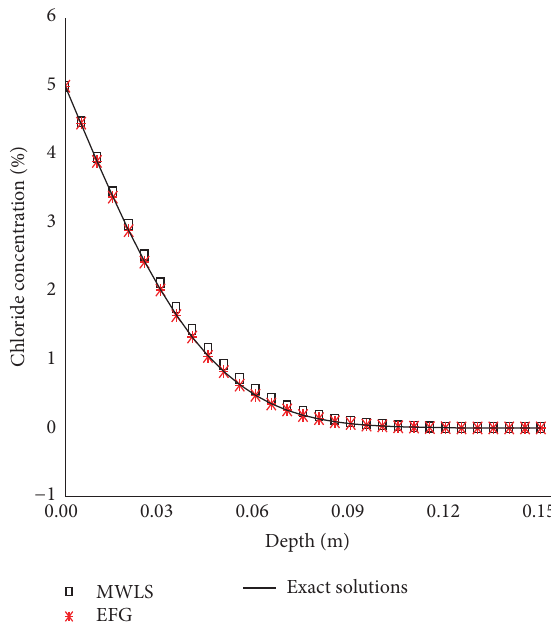
Figure 4: Chloride concentration-depth at time = 20 years.